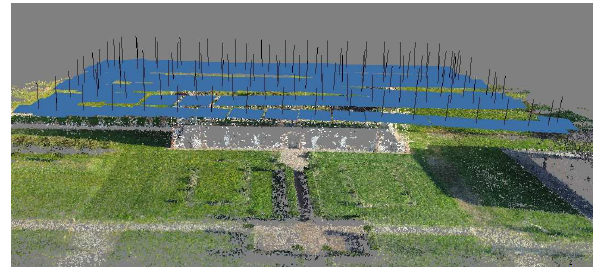
Figure 7: alignment made using precalibrated camera (dataset 01)